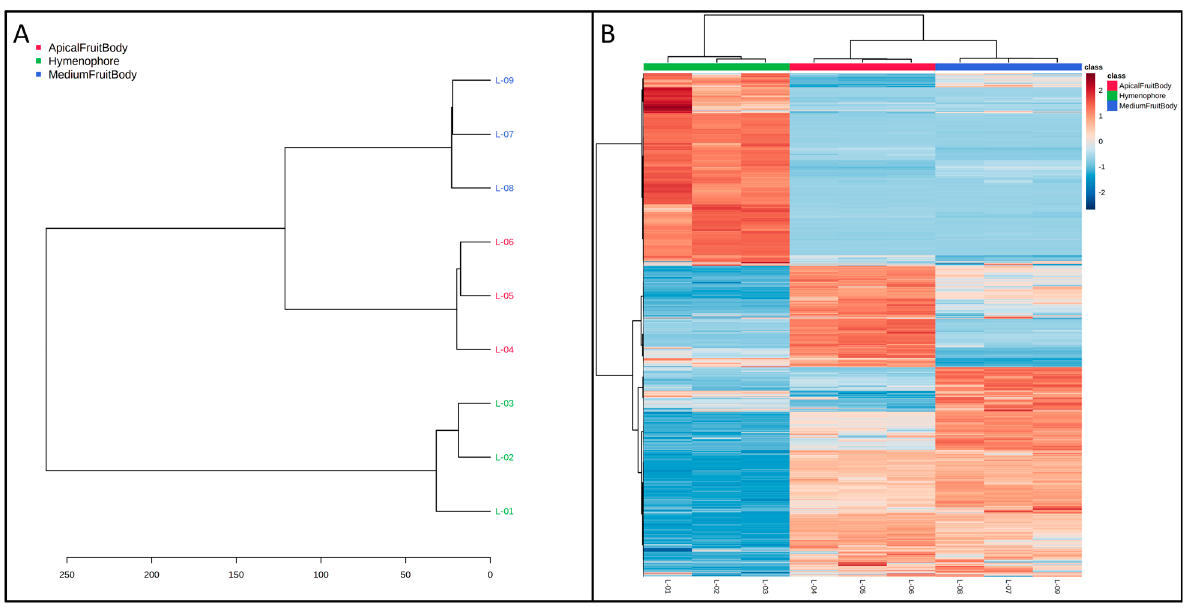
Figure 2. ( A ) Dendrogram and ( B ) heat map confirming that the samples were mainly divided into two clusters: hymenium and fruiting body. The latter was divided into the medium and apical clusters. Heat-map analysis shows that some characteristics were overexpressed only in the hymenophore, others only in the apical part of the fruiting body, and others only in the middle part of the fruiting body.